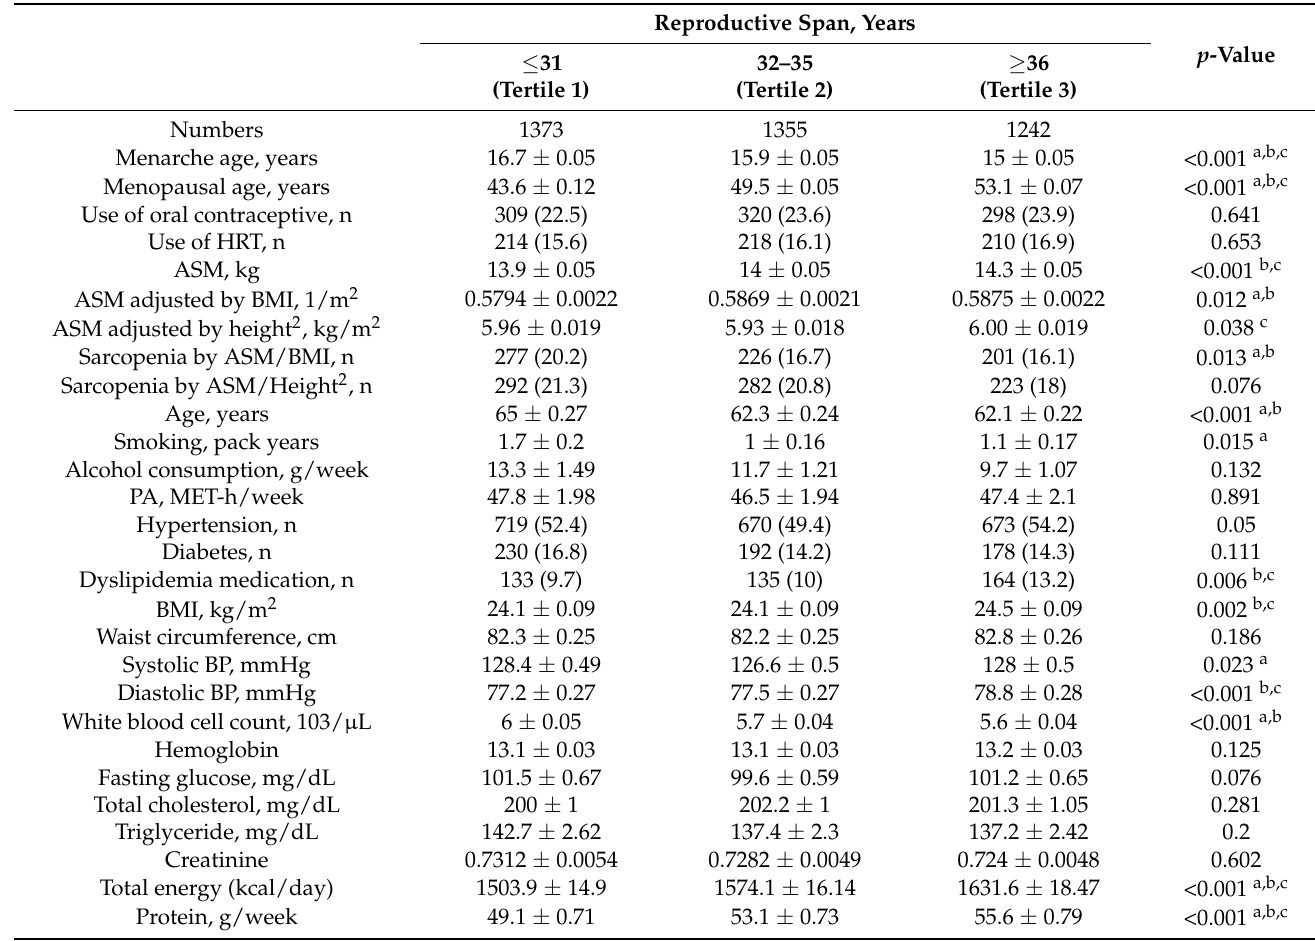
Table 1. General characteristics of study subjects according to reproductive